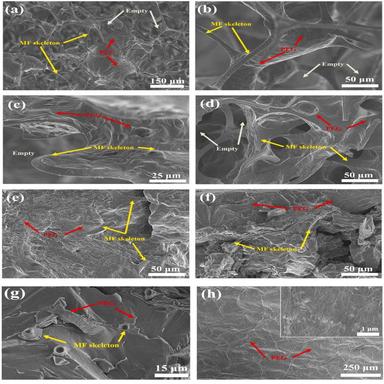
SEM images of the FCPCMs: (a) MF@PEG; (b) BC16-MF@PEG; (c) BC32-MF@PEG; (d) BC48-MF@PEG; (e) BC64-MF@PEG; (f) BC96-MF@PEG; (g) and (h) C400BC64-MF@PEG.